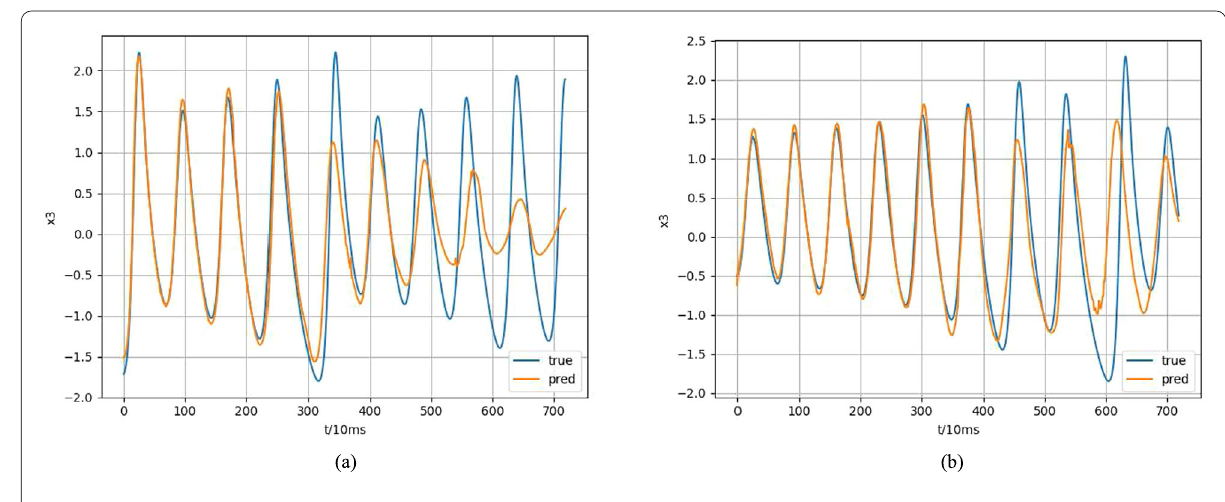
Figure 6 Effective prediction length of